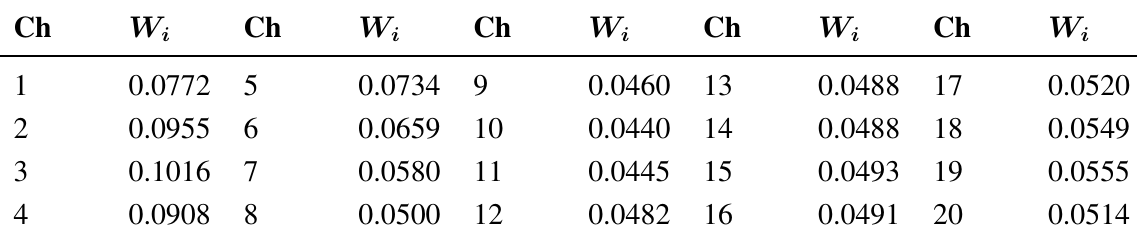
Table 1. The weights W applied to each of the Q bands (Ch) in the calculation of the i normalized covariance metric (NCM) [52].